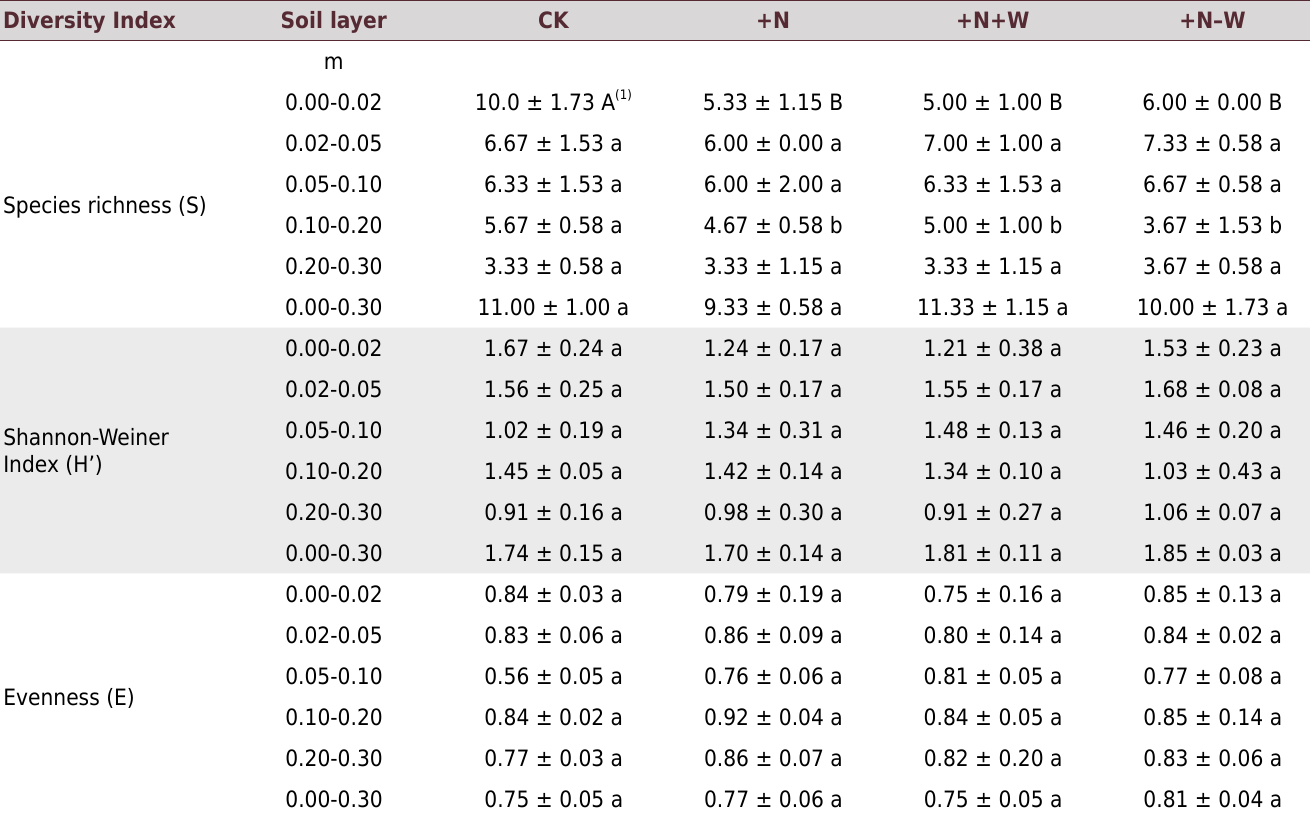
(1) Different uppercase letters indicate significant differences between treatments in the same soil layer at p<0.01; if lowercase letters are different, this indicates a significant difference between treatments in the same soil layer at